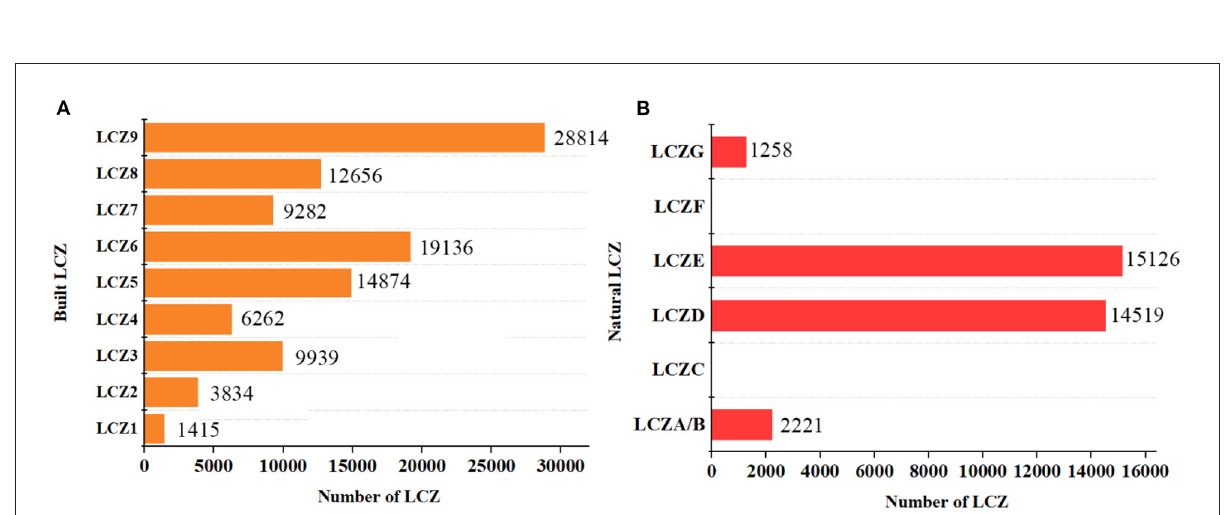
FIGURE3 Number of built and natural type LCZs in the study area, (A) is the number of buildings type LCZs; (B) is the number of nature type